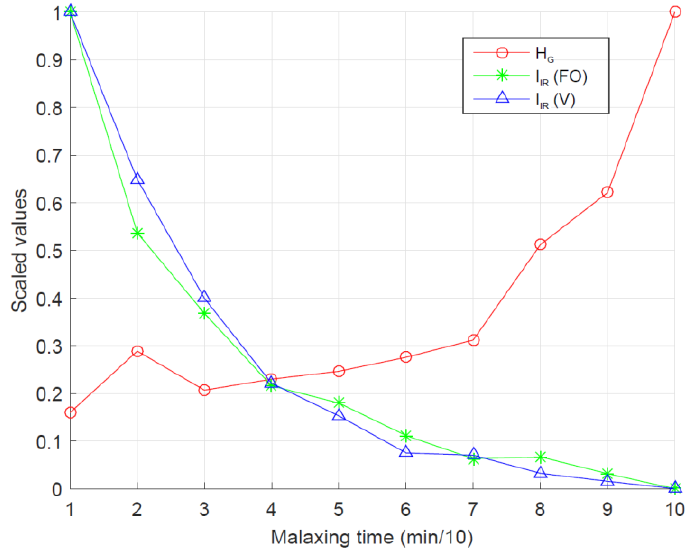
Figure 13. Inputs values for the controller where 𝐻 𝐺 is the textural parameter homogeneity in the green channel, 𝐼 𝐼𝑅 (FO) is the intensity value of the infrared channel for floating oil and 𝐼 𝐼𝑅 ( V) is the same value for viscosity